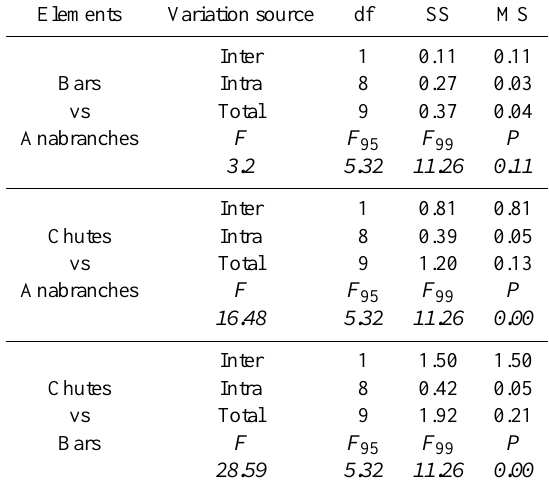
Table 3. ANOVA tests on the surface-layer grain-size distributions of the three kinds of morpho-sedimentary elements. df is the num- ber of degrees of freedom, SS the sum of square and MS the mean square. P is the probability to get this value F from samples ex- tracted from a single population. The null hypothesis is that there is no difference in the mean values of the grain-size distributions. Chutes are clearly different from anabranches and bars ( F > F 99 ), whereas anabranches and bars cannot be considered as two different populations ( F < F 95 ). Elements Variation